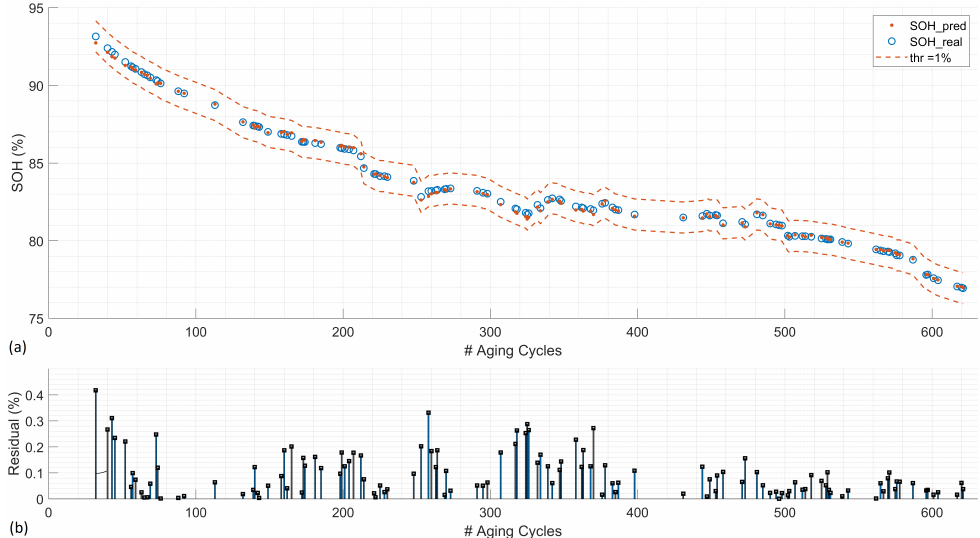
Figure 14. Neural network SOH estimation performance on testing dataset. # Aging Cycles is the number of cycles that one cell has